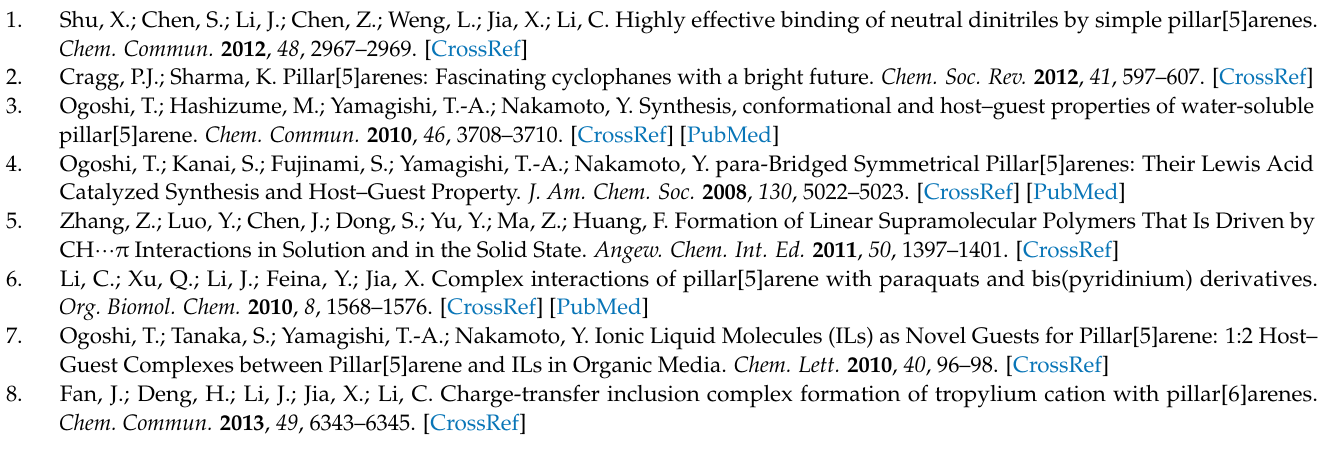
HRMS data for DMP[5]-TPE (Calculated [M + Na] + : C 58 H 58 NaO 10+ = 937.3922, Found: 937.3965), Figure S5: 1 H NMR spectrum of PCP[5]-TPE in CDCl 3 , Figure S6: 13 C NMR spectrum of PCP[5]-TPE in CDCl 3 , Figure S7: HRMS data for PCP[5]-TPE (Calculated [M + Na] + : C 50 H 42 NaO 2+ = 697.3077, Found: 697.3122), Figure S8: HRMS data for PCP[5]-TPE (Calculated [M] + : C 50 H 42 O 2+ = 674.3179, Found: 674.3195), Figure S9: Top (a) and side view (b) of crystal structure PCP[5]-TPE , Figure S10: Molecular packing of PCP[5]-TPE , Figure S11: Top (a) and side view (b) of crystal structure DMP[5]- TPE . Hexane solvent molecules are omitted for clarity, Figure S12: Molecular packing of DMP[5]-TPE . Hexane solvent molecules are omitted for clarity, Figure S13: Fluorescence spectra of DMP[5]-TPE (1 × 10 − 5 M), Figure S14: Plot of the highest fluorescence intensity in different THF/H 2 O mixed solution of DMP[5]-TPE , Figure S15: Fluorescence spectra of PCP[5]-TPE (1 × 10 − 5 M), Figure S16: Plot of the highest fluorescence intensity in different THF/H 2 O mixed solution of PCP[5]-TPE , Figure S17: Fluorescence spectra of PC[5]-TPE (1 × 10 − 5 M), Figure S18: Plot of the highest fluo- rescence intensity in different THF/H 2 O mixed solution of PCP[5]-TPE , Figure S19: (A) 1 H NMR spectra of DCB (1 mM), (B) Partial 1 H NMR spectra of mixed solution of DMP[5]-TPE (1 mM) and DCB (1 mM), (C) 1 H NMR spectra of DMP[5]-TPE (1 mM). * = solvent, Figure S20: (A) 1 H NMR spectra of DCB (1 mM), (B) Partial 1 H NMR spectra of mixed solution of PCP[5]-TPE (1 mM) and DCB (1 mM), (C) Partial 1 H NMR spectra of mixed solution of PCP[5]-TPE (1 mM) and DCB (2 mM), (D) 1 H NMR spectra of PCP[5]-TPE (1 mM). * = solvent, Figure S21: Job plot showing the 1: 1 stoi- chiometry of the complex between DMP[5]-TPE and DCB in CHCl 3 by plotting the ∆ δ in absorbance of the 280nm observed by uv-vis against the mole fraction of guest (X guest ). ([host] + [guest] = 2 × 10 − 5 M, Figure S22: ESI-MS spectrum of the host − guest complex formed between DMP[5]-TPE and DCB. (Calculated [ DMP[5]-TPE + DCB] + : C 64 H 66 N 2 O 10+ = 1022.4712, Found: 1022.4657), Figure S23: (a) The absorbance of DMP[5]-TPE and DCB mixture. (b) The Red line was obtained from the nonlinear curve-fitting ( K a = ((1.33 ± 0.05) × 10 4 M − 1 , R 2 = 0.9923), Figure S24: (a) The ab- sorbance of DMP[5] and DCB mixture. (b) The Red line was obtained from the nonlinear curve-fitting ( K a = ((2.14 ± 0.08) × 10 4 M − 1 , R 2 = 0.9928), Table S1: Association constant for DMP[5], DMP[5]-TPE and PCP[5]-TPE